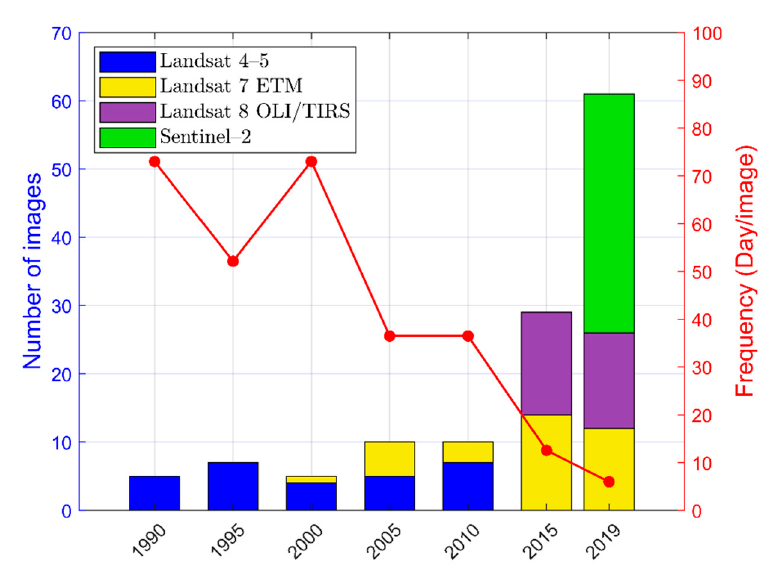
Figure 3. Number of satellites and frequency of images used in the research.